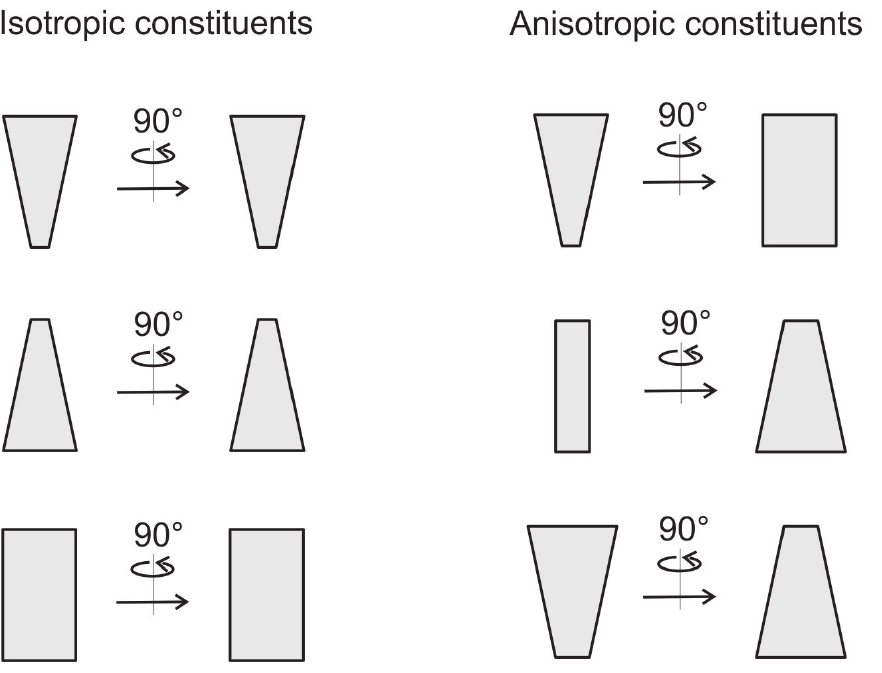
Figure 2. Schematic representation of different isotropic ( C 1 m = C 2 m ) and anisotropic ( C 1 m (cid:54) = C 2 m ) shapes of lipid bilayer-embedded constituents (inclusions). Front and side views of inclusions are